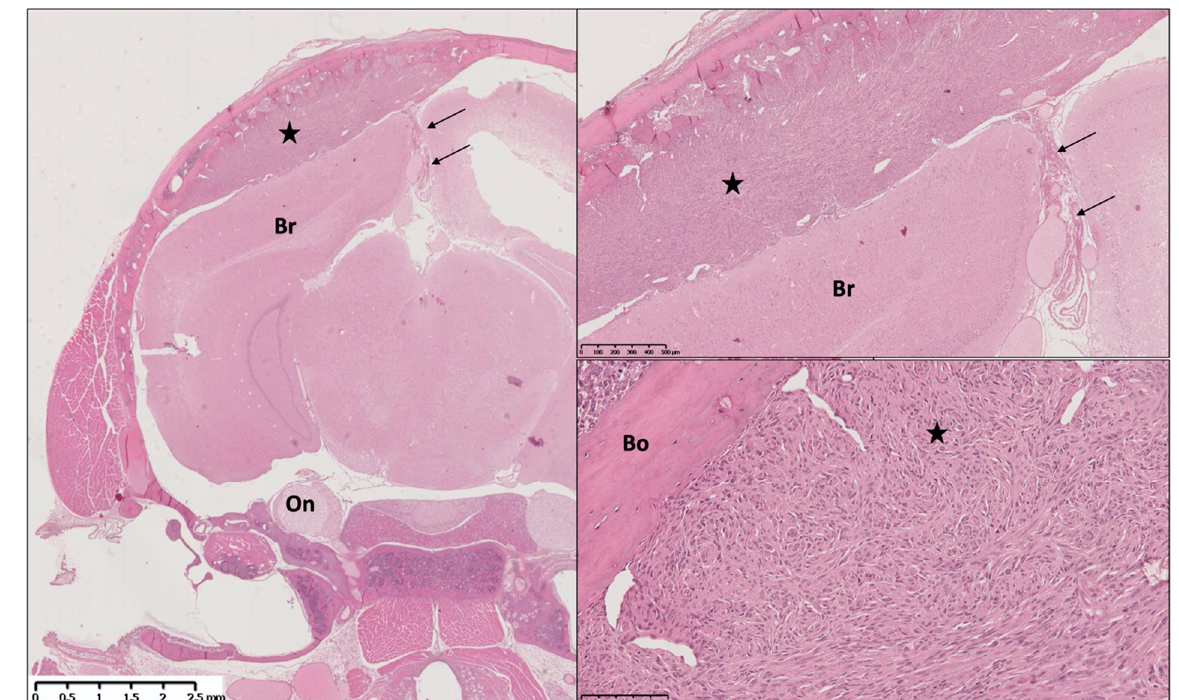
Figure 2. Illustration of a meningothelial meningioma in the AdCre; Nf2flox/flox; Ink4ab − / − model. Left image shows a coronal section of the whole cranium, with a massive right convexity meningioma (star) causing mass effect on the brain (Br). The lesion is centered at the Adenovirus injection site, a few millimeters lateral from the falx (arrows). Upper right image shows the meningioma at higher magnification; note that the brain cortex is not invaded in this case. Lower right image shows the tumoral architecture at higher magnification. Note the classical aspect of cellular whorl (star) and the close relationship with the skull convexity bone (Bo).